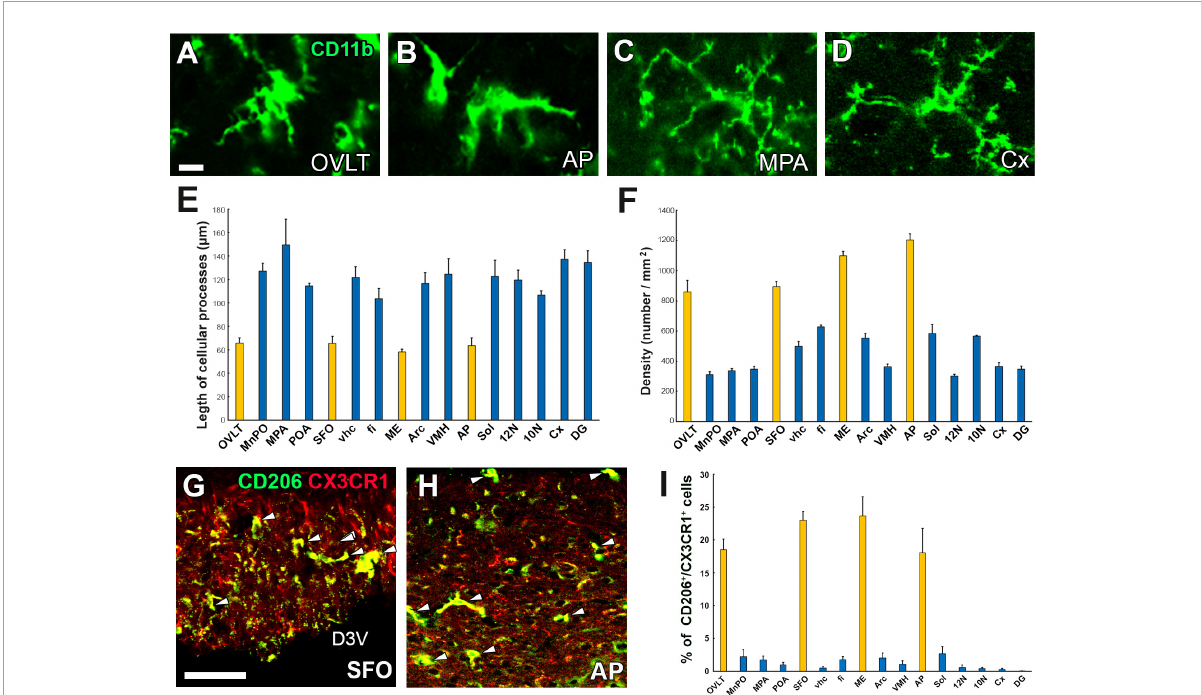
FIGURE5 Activated state of microglia in the CVOs even under physiologically normal conditions. Microglia morphology in the CVOs, such as the OVLT and AP, is amoeboid, whereas in the medial preoptic area and cerebral cortex, it is dendritic (A–D) . Quantitative analysis reveals shorter microglial cellular processes in the CVOs than other brain regions (E) . The density of the CVOs microglia is significantly higher than that of other brain regions (F) . Double-labeling immunohistochemistry shows that CX3CR1 + microglia express an M2 marker protein CD206 (arrowheads) in the SFO and AP (G,H) . Quantitative analysis shows the percentage of CD206 expression in CX3CR1 + microglia is higher in the CVOs than that of other brain regions (I) . 10N, dorsal motor nucleus of vagus nerve; 12N, hypoglossal nucleus; AP, area postrema; Cx, cerebral cortex; D3V, dorsal 3rd ventricle; DG, dentate gyrus; fi, fimbria; ME, median eminence; MnPO, median preoptic area; MPA, medial preoptic area; OVLT, organum vasculosum of the lamina terminalis; SFO, subfornical organ; Sol, solitary nucleus; vhc, ventral hippocampal commissure; VMH, ventromedial hypothalamic nucleus. Scale bars = 10 (A) and 50 µ m (G) . Scale bars = 50 µ m. Yellow and blue bars indicate the CVOs and non-CVO regions, respectively. Photographs are rearranged with permission from Elsevier B.V. (Takagi et al.,